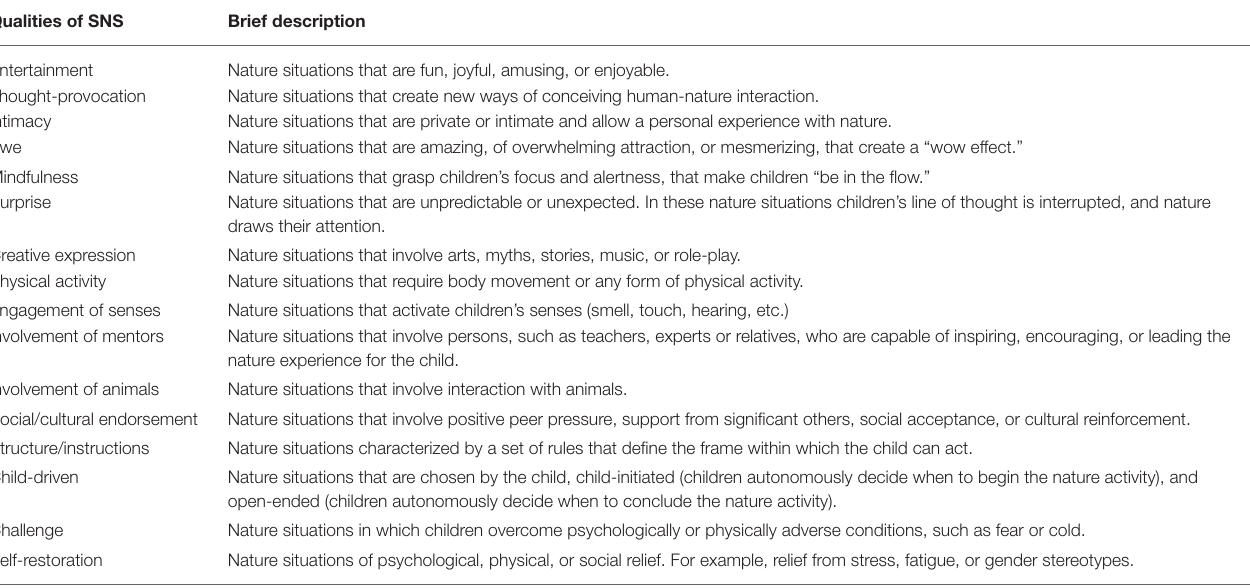
TABLE 1 | List of qualities of significant nature situations with associated brief descriptions. Qualities of